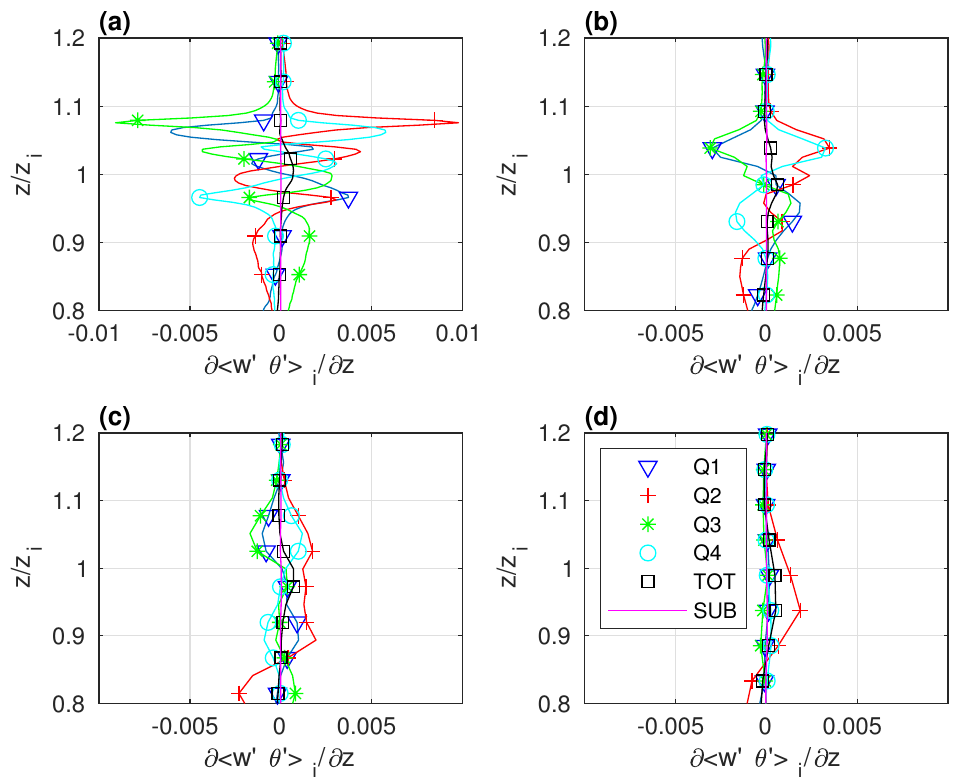
Figure 15. Contributions to the rate of change of potential temperature (Ks − 1 ) in the CBL1 simulations with grid lengths of ( a ) 10 m, ( b ) 40 m, ( c ) 80 m and ( d ) 160 m. The contributions due to resolved turbulent fluxes in each of the quadrants are shown, as well as the contributions from all resolved fluxes and that from the sub-filter flux. The symbols and line styles used for each contribution are indicated on the inset to Panel ( d